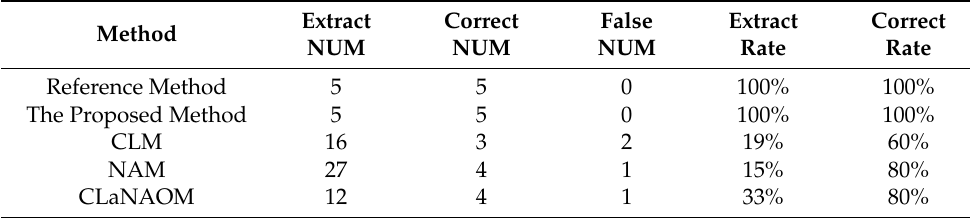
Table 7. The mountain vertices extraction results for each method using the second dataset.